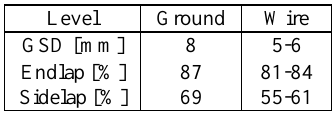
Table 1. Parameters of images according to flight plan